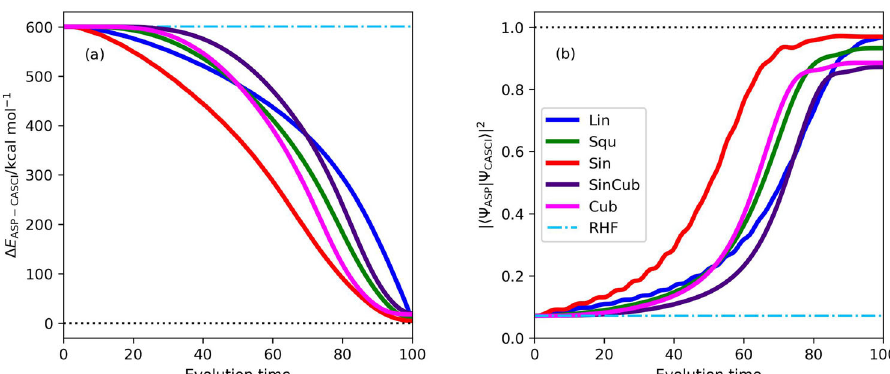
Fig. 4 Trajectories of ASP with T = 100 in N 2 molecule with R(N – N) = 3.0 Å. a The energy deviations from the CASCI value. b The square overlaps with the CASCI wave function.